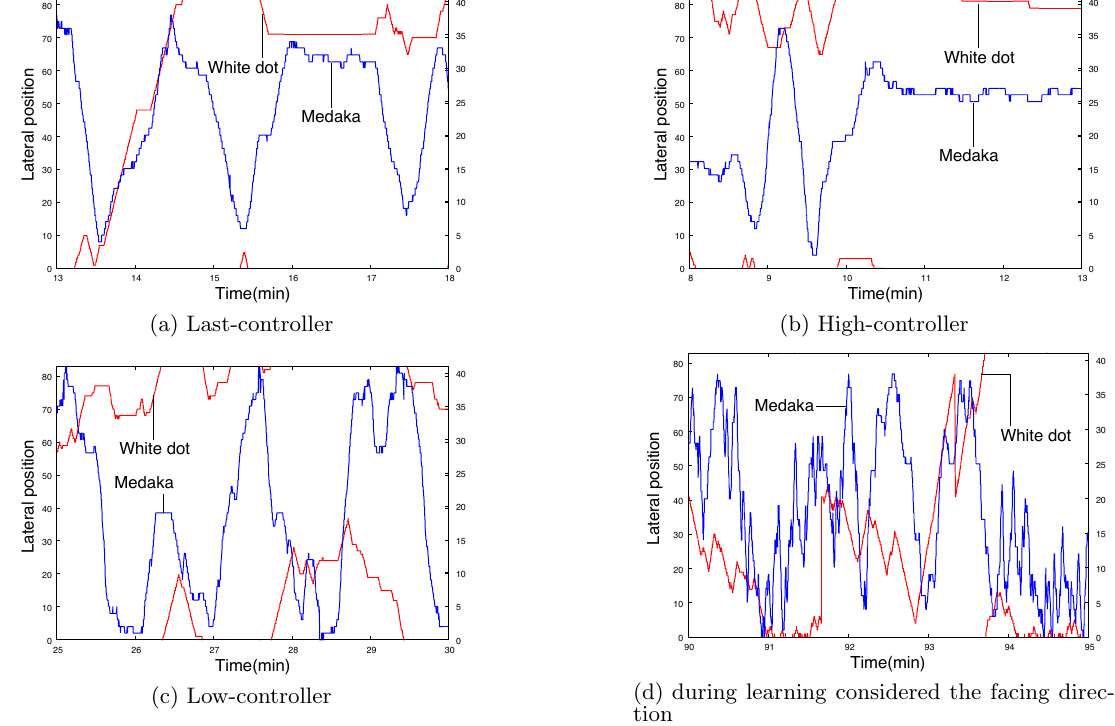
Figure 7: The white dot movement and the medaka movement in the lateral